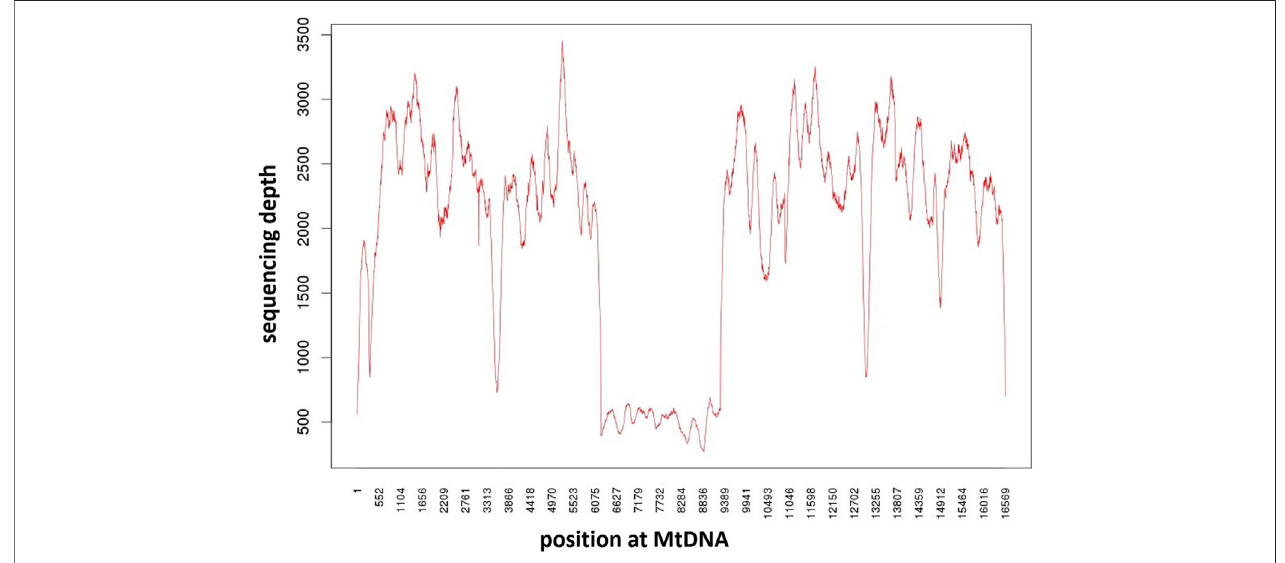
FIGURE 3 | Mitochondrial DNA mutation in the patients. Analysis of mitochondrial DNA mutations in the child ’ s blood showed a heteroplasmic deletion of mitochondrial DNA 3.063 kb (nt 6,224 – 9,287).